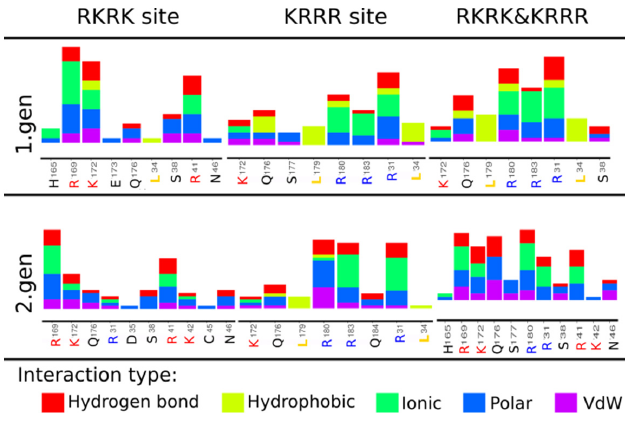
Int. J. Mol. Sci. 2021 , 22 , x FOR PEER REVIEW Figure 3. Arpeggio analysis for the dPGS to hIL-6 . Figure 3. Arpeggio analysis for the dPGS to hIL-6.